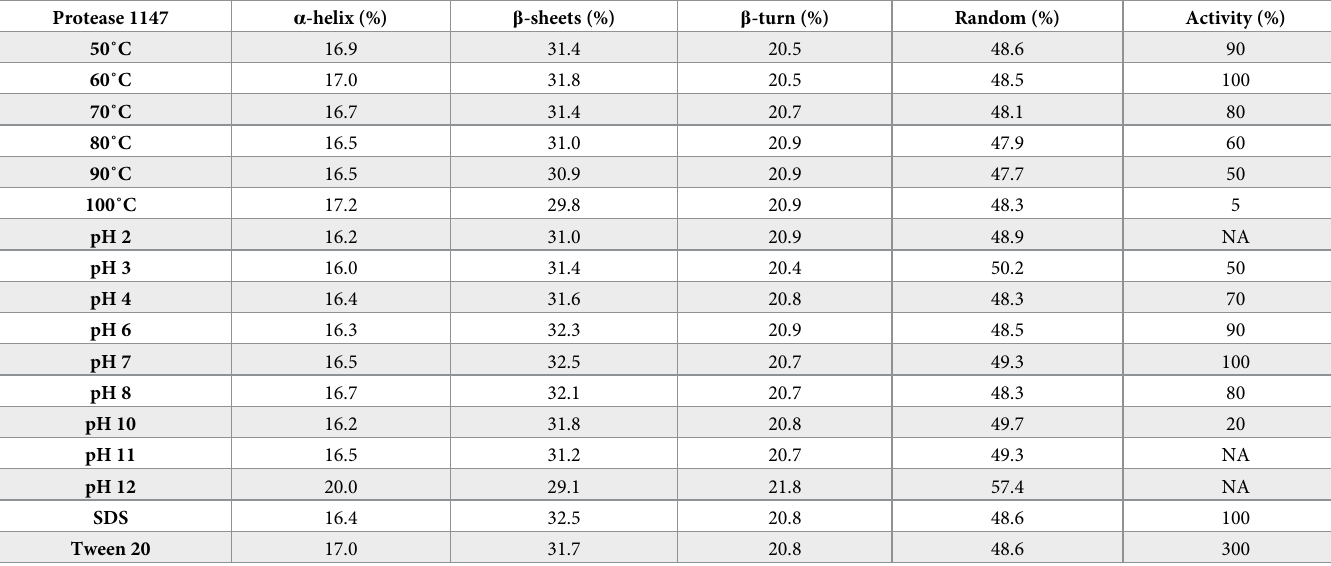
Table 5. Effects of different temperatures, pH values, SDS, and Tween 20 on the protease 1147 secondary structure and protease activity. Protease 1147 α -helix